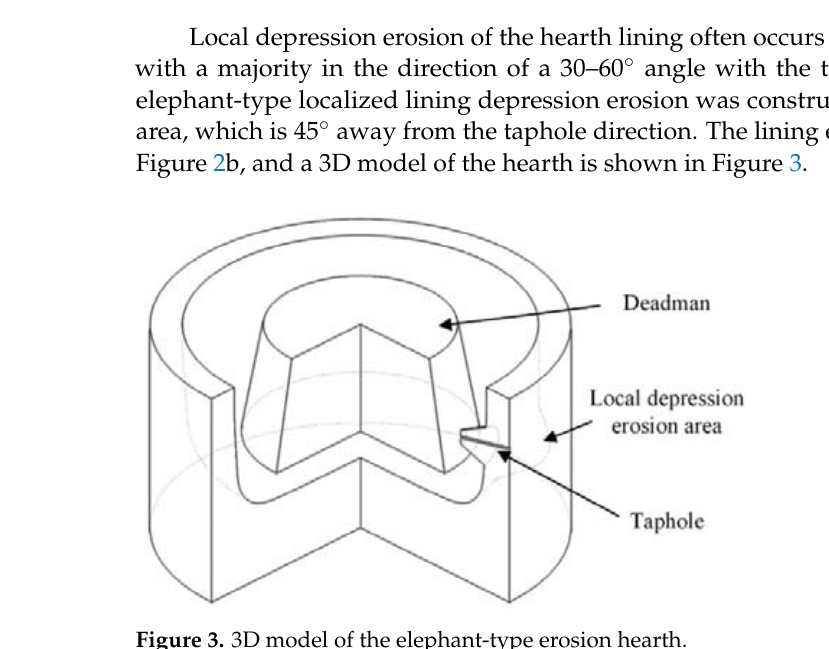
Table 2. Physical properties of hot iron.